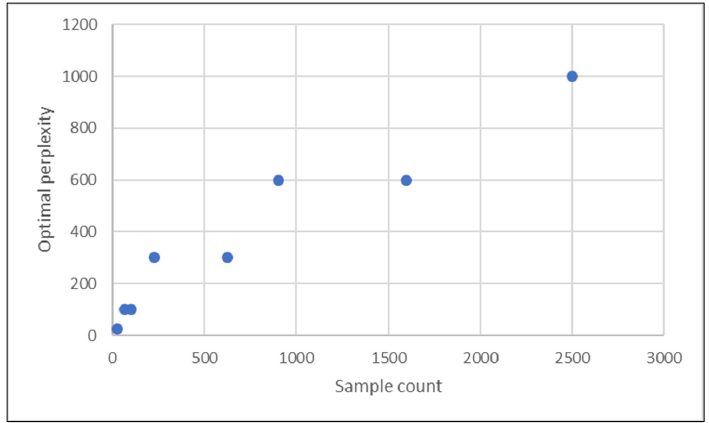
Figure 7. Optimal perplexity relation against sample count.